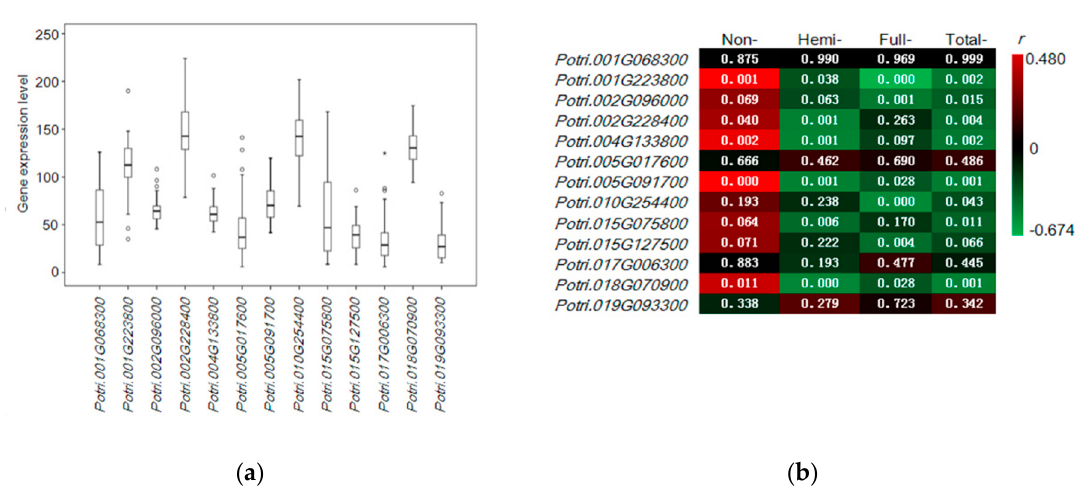
Figure 3. Expression levels of candidate genes and their correlations with relative DNA methylation levels. ( a ) Gene expression level determined by quantitative real-time polymerase chain reaction (qRT-PCR). The x - and y -axes indicate, respectively, gene name and expression level relative to PtACTIN . ( b ) Linear correlations between gene expression levels and relative DNA methylation levels. Non-, Hemi-, Full-, and Total- indicate relative non-methylation, hemi-methylation, full-methylation, and total-methylation levels, respectively, estimated by the Pearson correlation coe ffi cient ( r , red-black-green color scale from positive to negative correlation). The white number ( p -value) in each cell indicates the significance of difference.